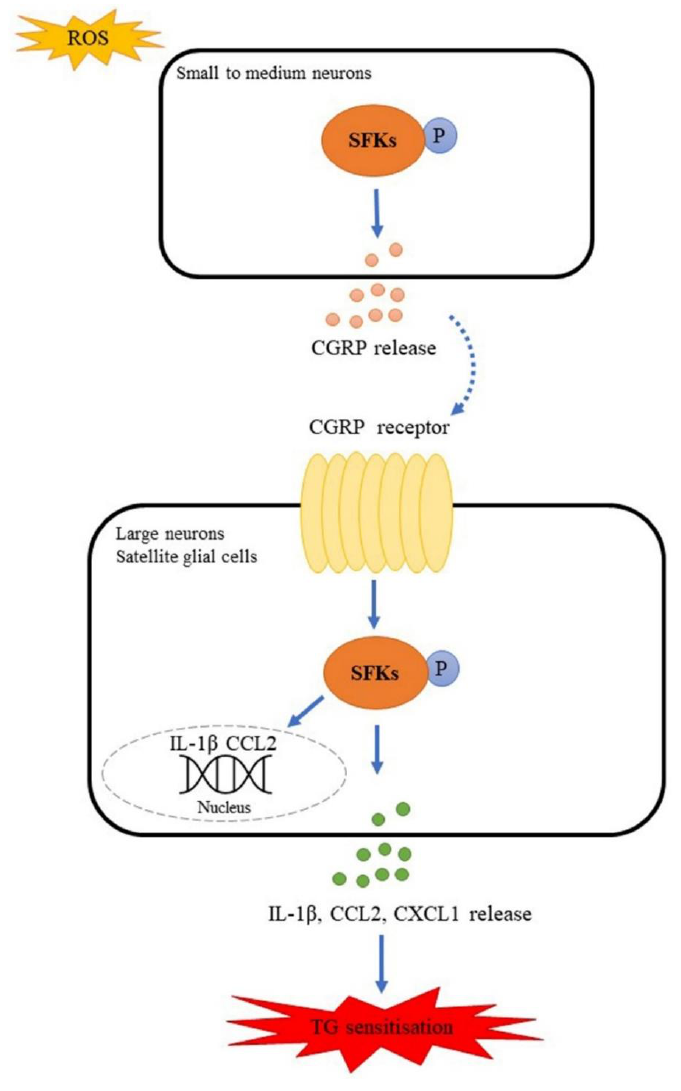
Figure 9. Model of SFKs activity facilitating the crosstalk between CGRP and cytokines by transmit- ting CGRP receptor signaling to potentiate TG sensitization. SFKs are activated in response to ROS to induce CGRP release in small to medium neurons; released CGRP binds to CGRP receptor (dotted line with arrow) to activate SFKs in large neurons and satellite glial cells, which causes IL-1 β , CCL2, CXCL1 release and IL-1 β , CCL2 gene expression, thus leading to TG sensitization.